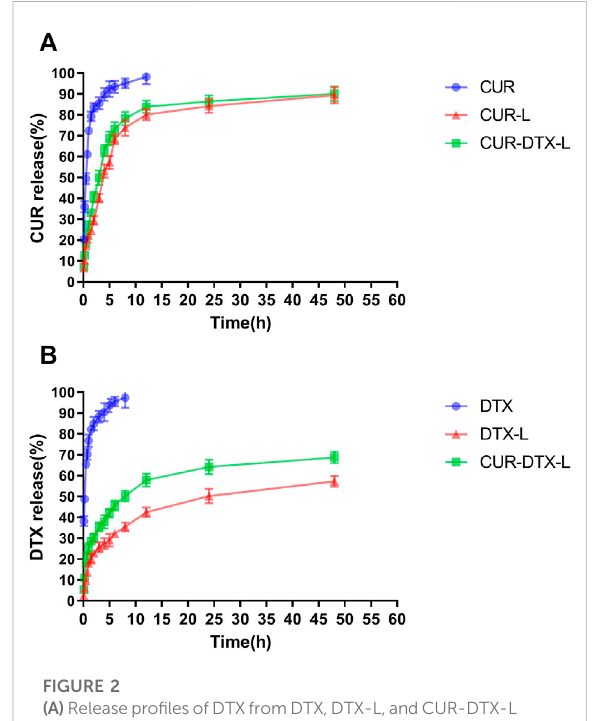
FIGURE 2 (A) Releasepro fi lesofDTXfromDTX,DTX-L,andCUR-DTX-L in PBS (pH 7.4) at 37 ° C ( n = 6). (B) Release pro fi les of CUR from CUR, CUR-L, and CUR-DTX-L in PBS (pH 7.4) at 37 ° C ( n =